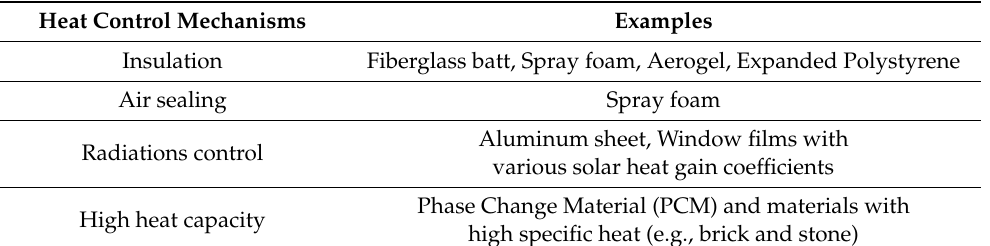
Table 1. Different heat control mechanisms in building envelope retrofit measures.